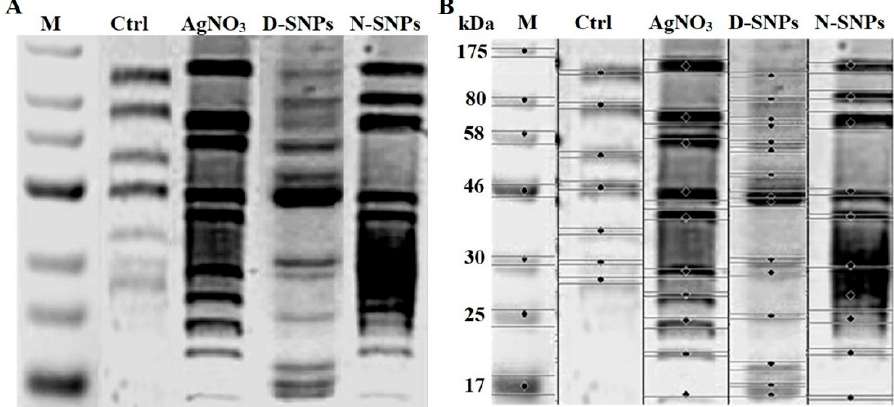
Figure 8. SDS–PAGE analysis of cellular proteins of Candida albicans (1 × 10 4 CFU/mL) before and after exposure to 1.5 mg/mL AgNO 3 , D-SNPs, and N-SNPs for 24 h ( A ) and computerized analysis of protein band intensities ( B ). M: Marker; Ctrl: Untreated C. albicans .